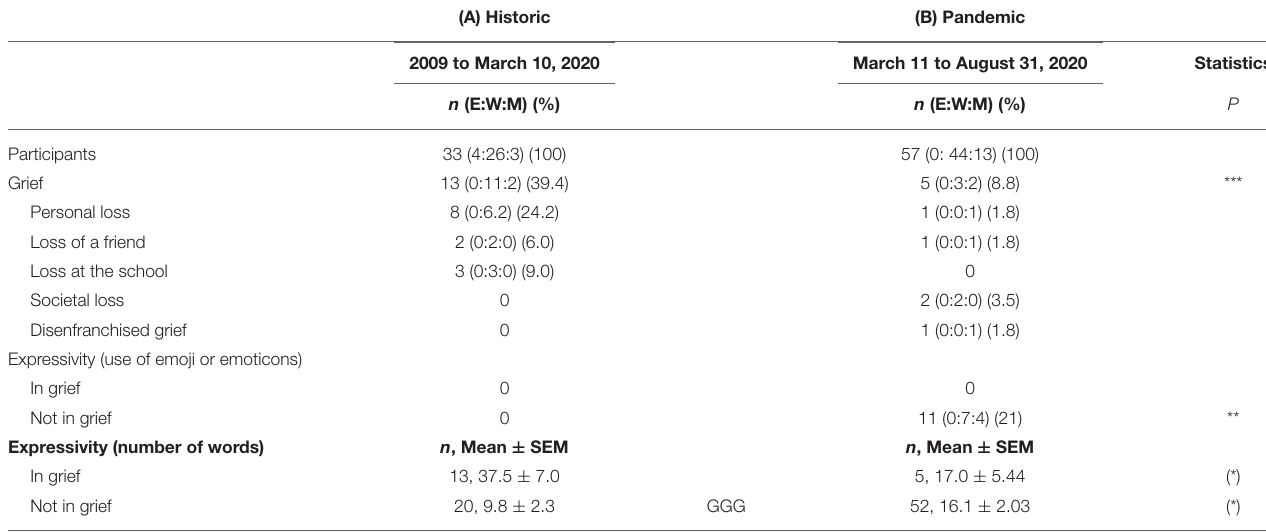
TABLE 6 | Content analysis of comments of